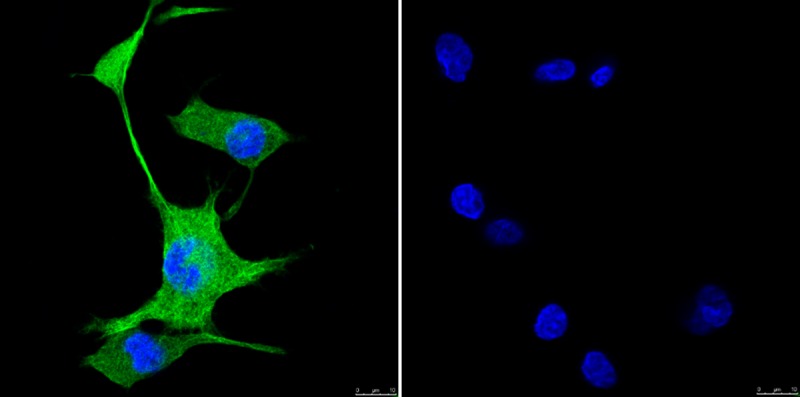
Immunodetection of β-III tubulin in PC12 cells treated with 25 ng/mL of rrβ-NGF on Day 8 of in vitro culture.Green signal represents binding to β-III tubulin (soma and neurites) and blue signal shows the nucleus stained with Hoescht 33342. Right panel is the negative control (lacking the primary antibody).